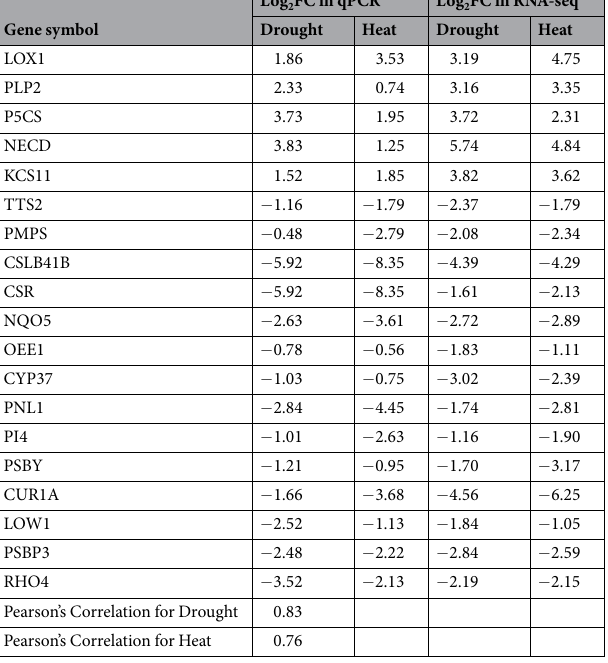
Table 3. The qRT-PCR validation of selected genes in the enriched GO